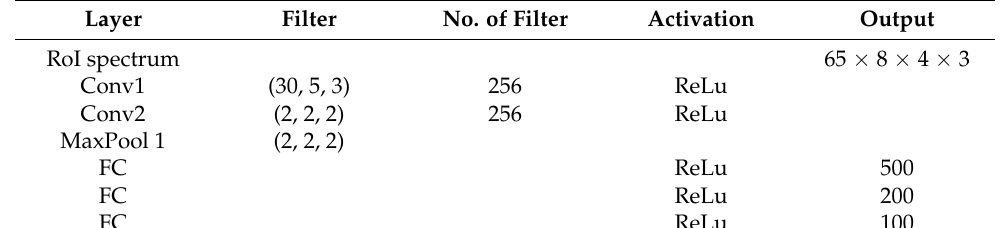
Figure 3. The covariance matrix of RoI. Table 2. 3D-CNN parameters.